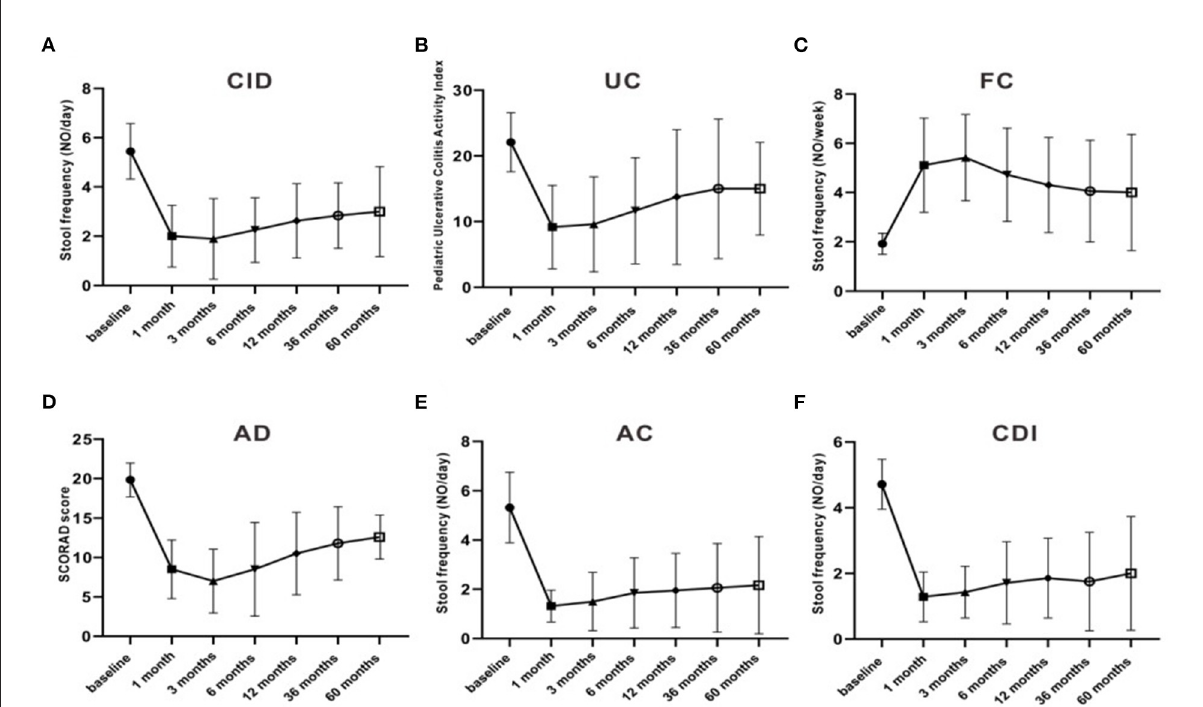
FIGURE4 The stool frequencies and scores in different diseases and the change over time. (A) fecal frequency of CID; (B) PUCAI score; (C) fecal frequency of FC; (D) SCDAI score of AD; (E) fecal frequency of AC; (F) fecal frequency of CDI. CDI, C.difficile infection; AC, infantile allergic colitis; CID, chronic intractable diarrhea; UC, ulcerative colitis; AD, recurrent atopic dermatitis; FC, functional